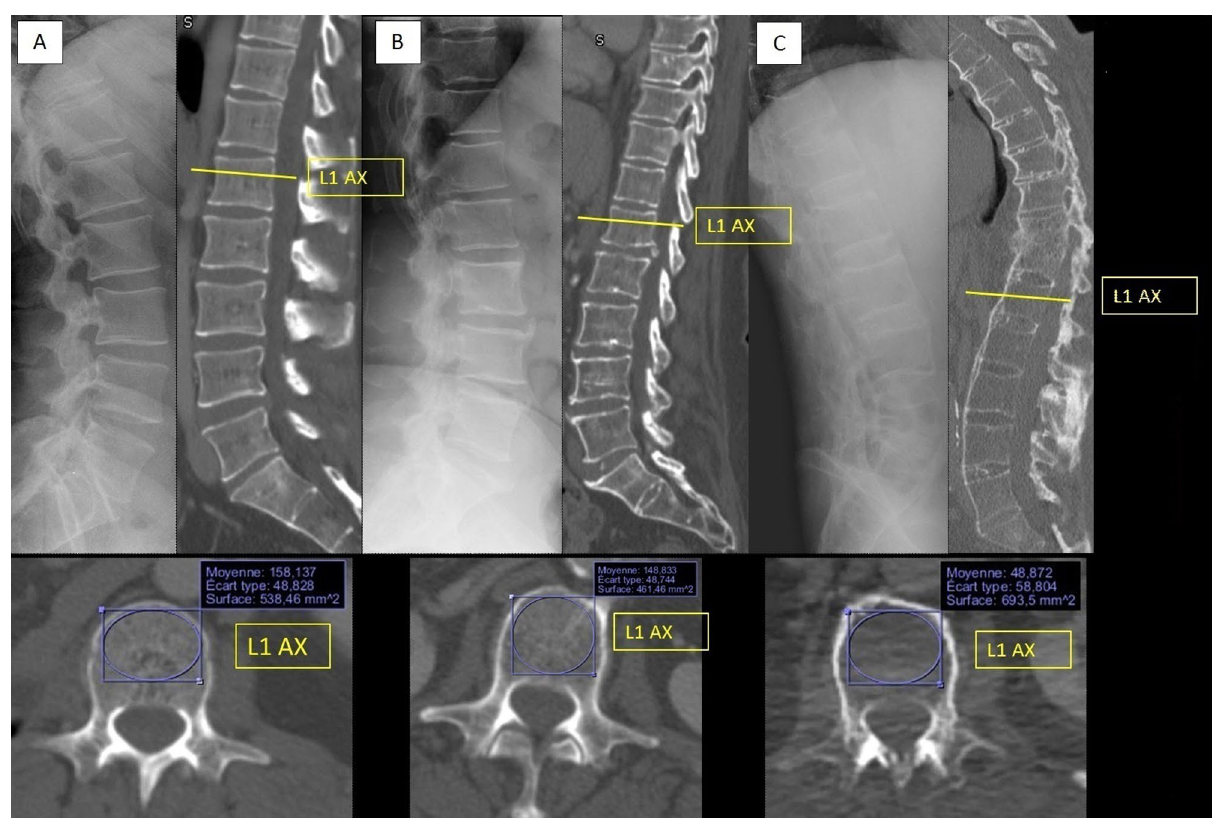
Figure 1. SBAC-L1 measure on normal spine (A), spine with syndesmophytes (B) and ankylosed spine (C). (OsiriX software (v6.5.1-64 bits). https:// www. osirix- viewer.